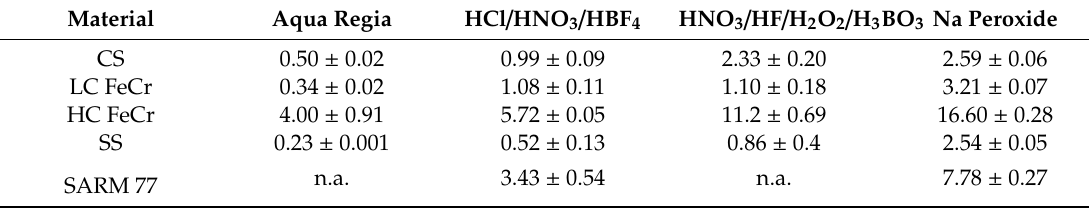
Table 3. Comparison of Cr content (in wt %) between wet chemical methods. Results show average ± standard